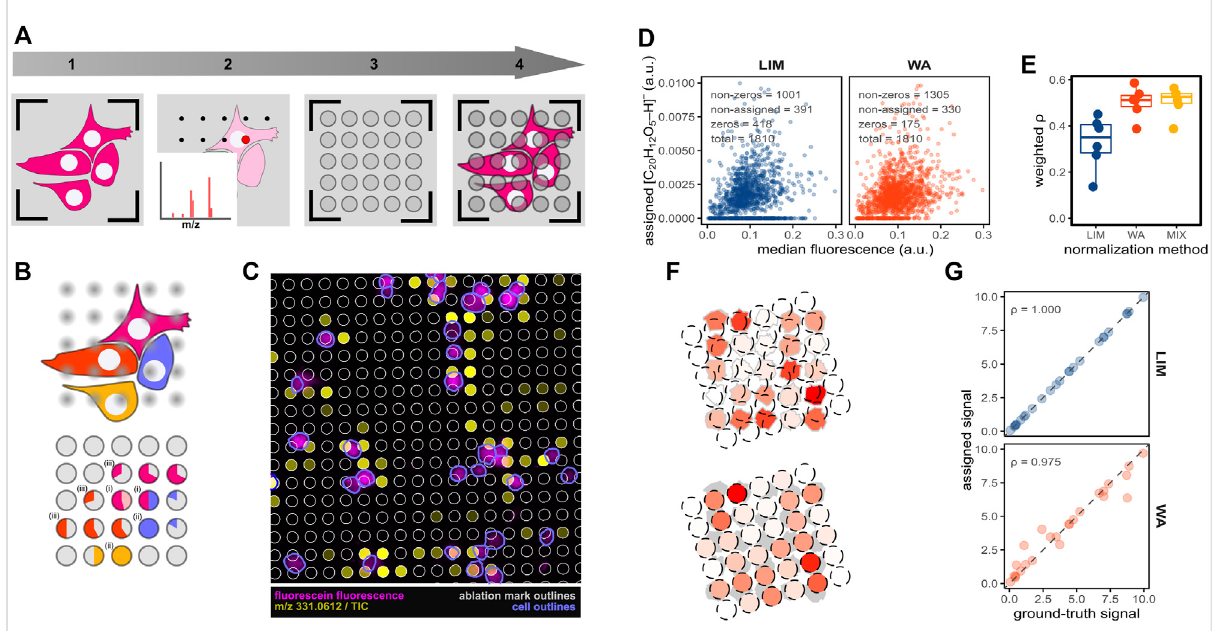
FIGURE 1 Evaluating pixel-cell deconvolution in imaging MS-based spatial single-cell metabolomics by using fl uorescein. (A) Procedure of SpaceM prior to pixel-cell deconvolution: (1) pre-MALDI microscopy, (2) MALDI-imaging MS acquisition, (3) post-MALDI microscopy, (4) image registration, ablated region selection and cell segmentation. (B) Pixel-cell deconvolution and the confounding factors. Single-cell pie charts illustrate the contributions of different cells or the extracellular area to the ablated regions sampling (i) multiple cells, (ii) a single cell, or (iii) both intra- and extracellular areas. Pixel-cell deconvolution methods aim to estimate the metabolite levels of the single cells depicted in magenta, red, blue and orange. (C) Overlay of the fl uorescein fl uorescence (magenta), fl uorescein MALDI-signals (yellow), laser-ablated regions (grey) and segmented cells (blue). (D) Representative scatter plots (belonging to one replicate) of median fl uorescein fl uorescence versus assigned fl uorescein MALDI-signal of single cells for the tested pixel-cell deconvolution methods: linear inverse modelling (LIM), weighted average (WA). The methods use sampling proportion cut-offs of 0.3, mass spectral intensities are integrated within 4 ppm m/z tolerance and TIC-normalised. (E) Boxplot with density- weighted Spearman correlations between fl uorescent and MALDI intensities of fl uorescein obtained for each of the pixel-cell deconvolution methodsWA,LIMandthemixedmodel(MIX)for6replicates. (F) Illustrationoftheprocessofdatasimulationtoevaluatethepixel-celldeconvolution methods.Cellsignalsarecolour-scaledfromwhitetoredforcells(groundtruth,toppanel)andablatedregions(measuredintensities,bottompanel). (G) Scatter plots with Spearman correlations of the ground truth versus assigned signals in the simulated data when using the pixel-cell deconvolution methods LIM (blue) or WA